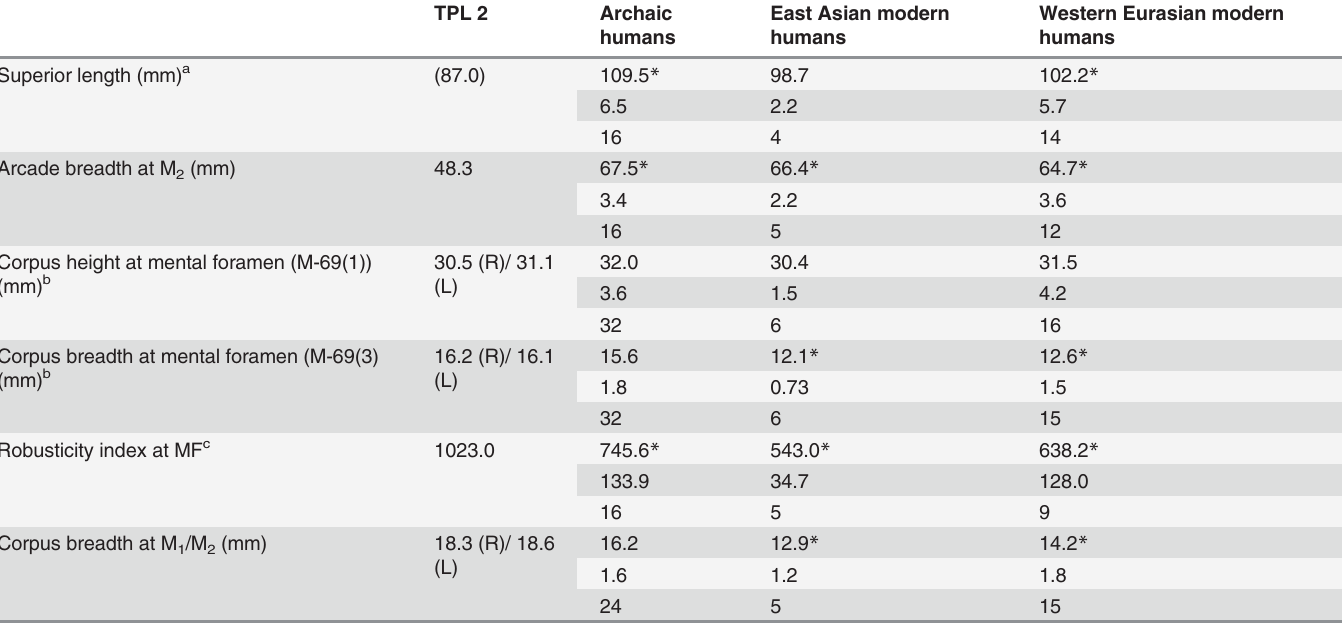
a Midsagittal distance from the mid-condyles to infradentale.